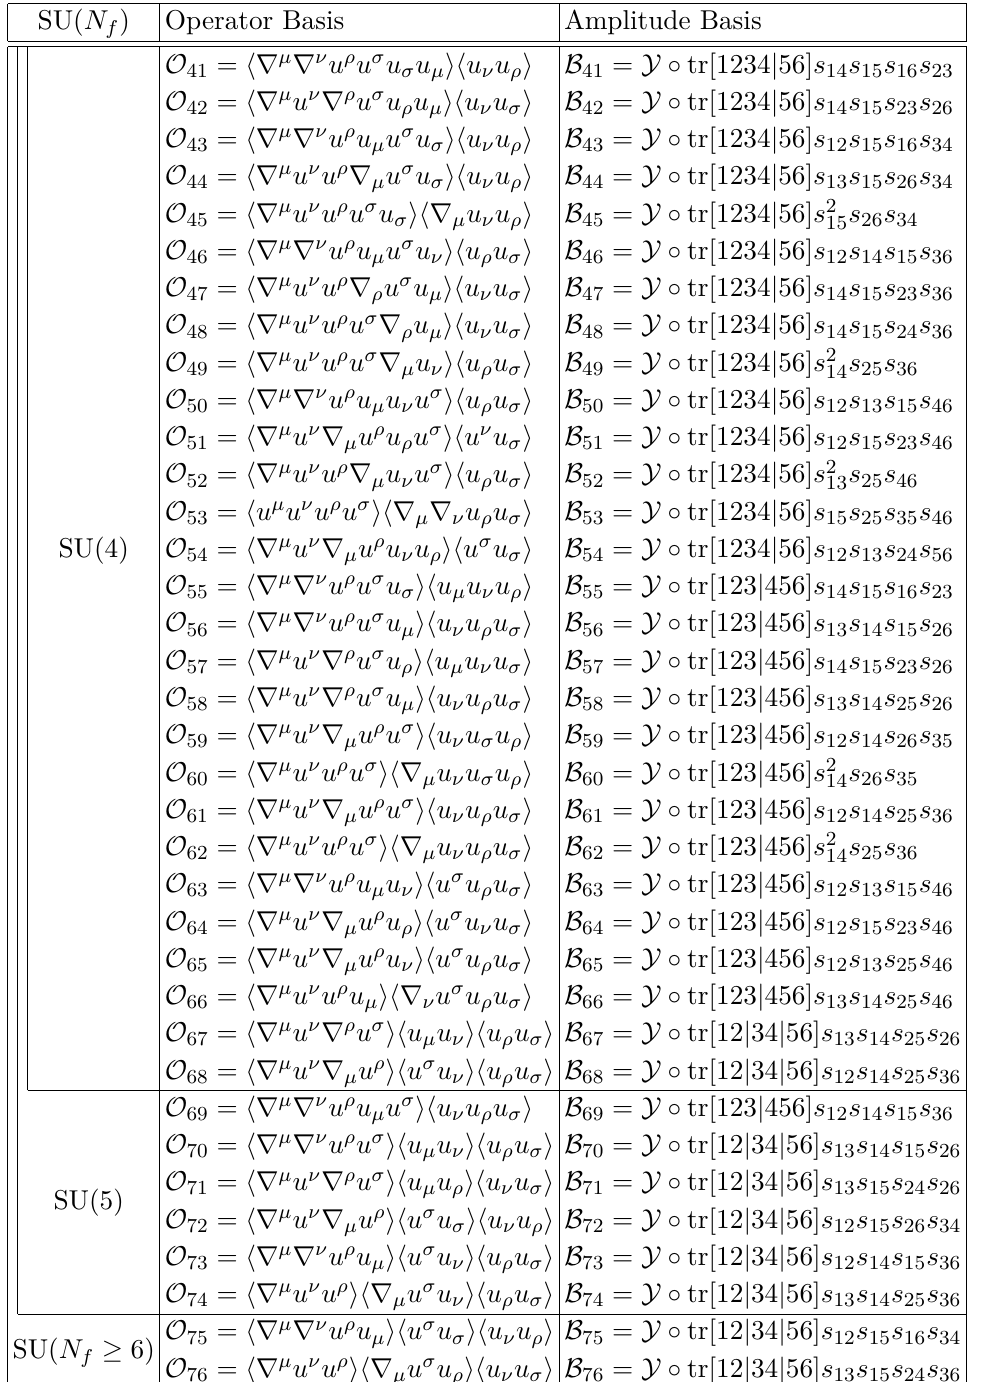
Table 13 . A complete set of 6-Goldstone parity-even operators in p 8 order. The number of inde- pendent monomials for SU(2) , SU(3) , SU(4) , SU(5) and SU( N and 76 respectively, agreeing with